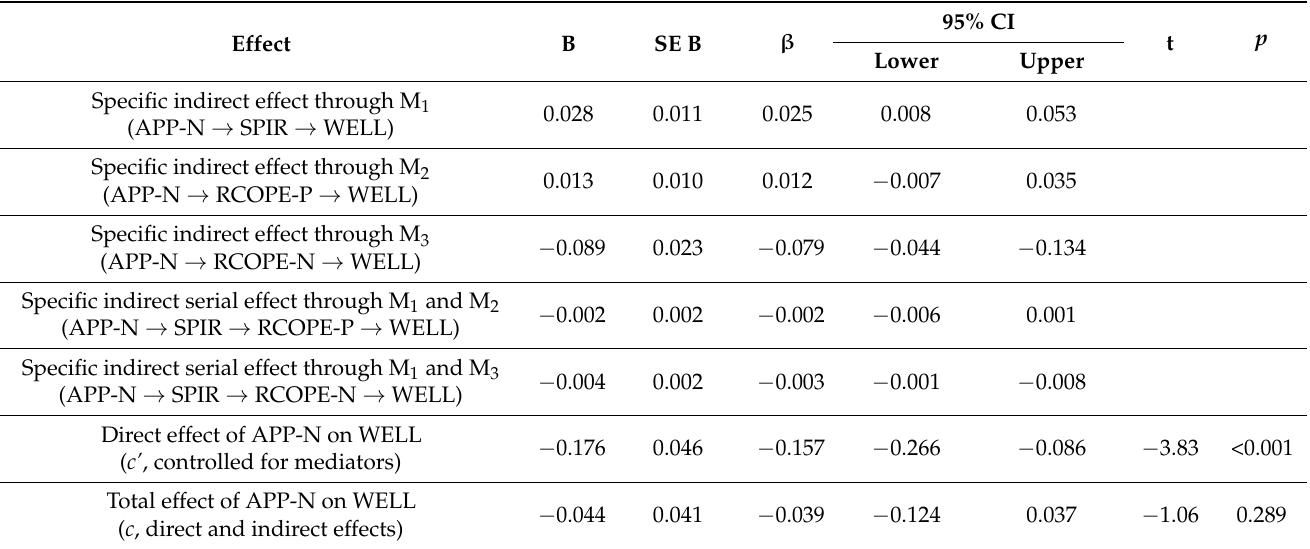
Table 4. Total, direct and indirect effects in the mediation model with serial and parallel media- tion